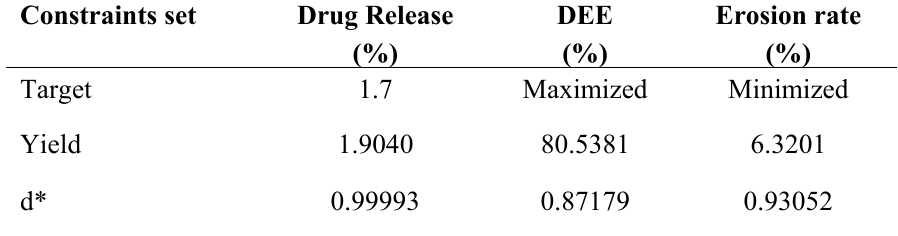
Table 2. Composition of optimized ECH